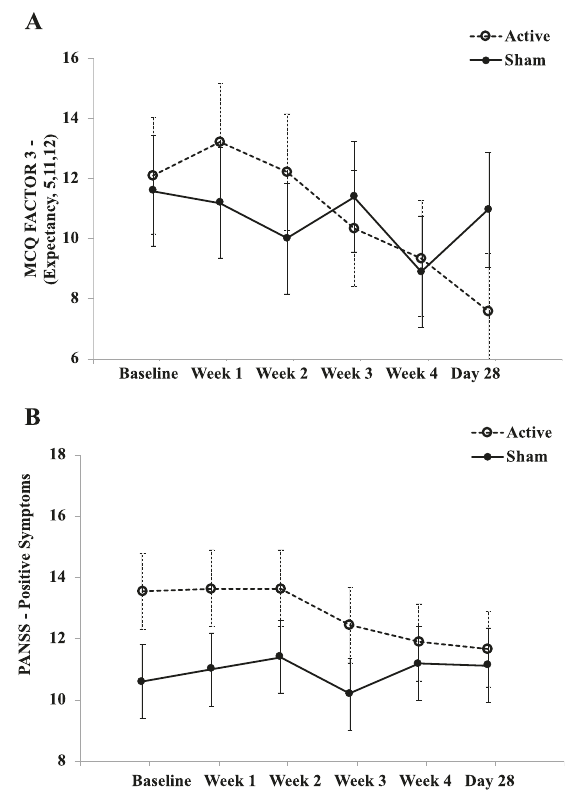
Fig. 3 Interaction plots of cannabis craving and psychiatric symptoms over time between active and sham treatment. Interaction plot of cannabis use related symptoms over the course of the trials with values given as estimated marginal means (EMM) ± standard error are used as error bars. EMM were used in interaction plots as a function to visualize the model at the group level (active and sham, each time point), not at the participant or data point